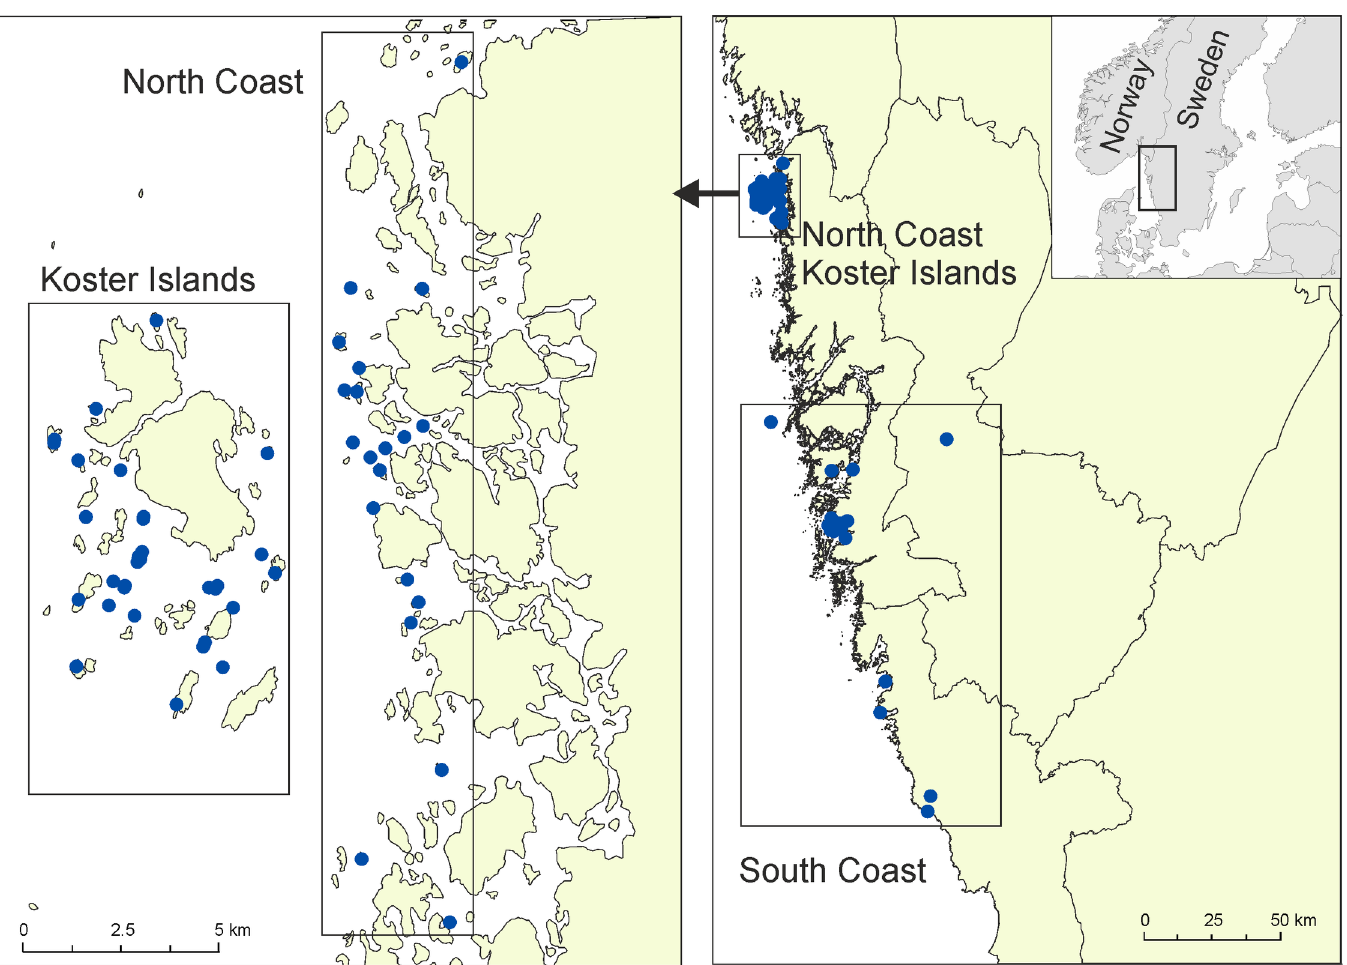
Fig 1. Maps showing the distribution of American mink samples in three study sites (Koster Islands, North Coast and South Coast) in Sweden. As in some locations more than one mink was culled, each point represents the location of at least one culled mink. Background map: Europe Base Map — Level 1 Provinces, AND Products B.V. and AND Data Ireland Limited,